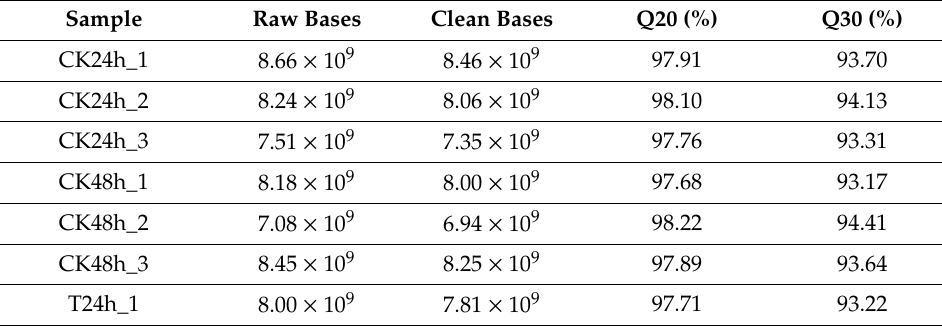
Table 1. Output RNA-seq statistics from leaf samples of P.